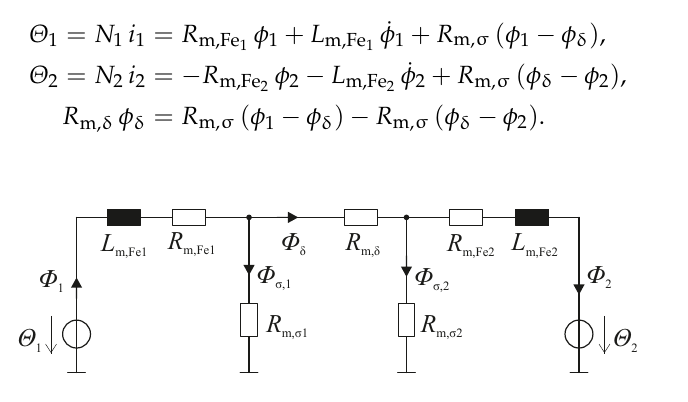
Figure 6. Equivalent circuit for the magnetic